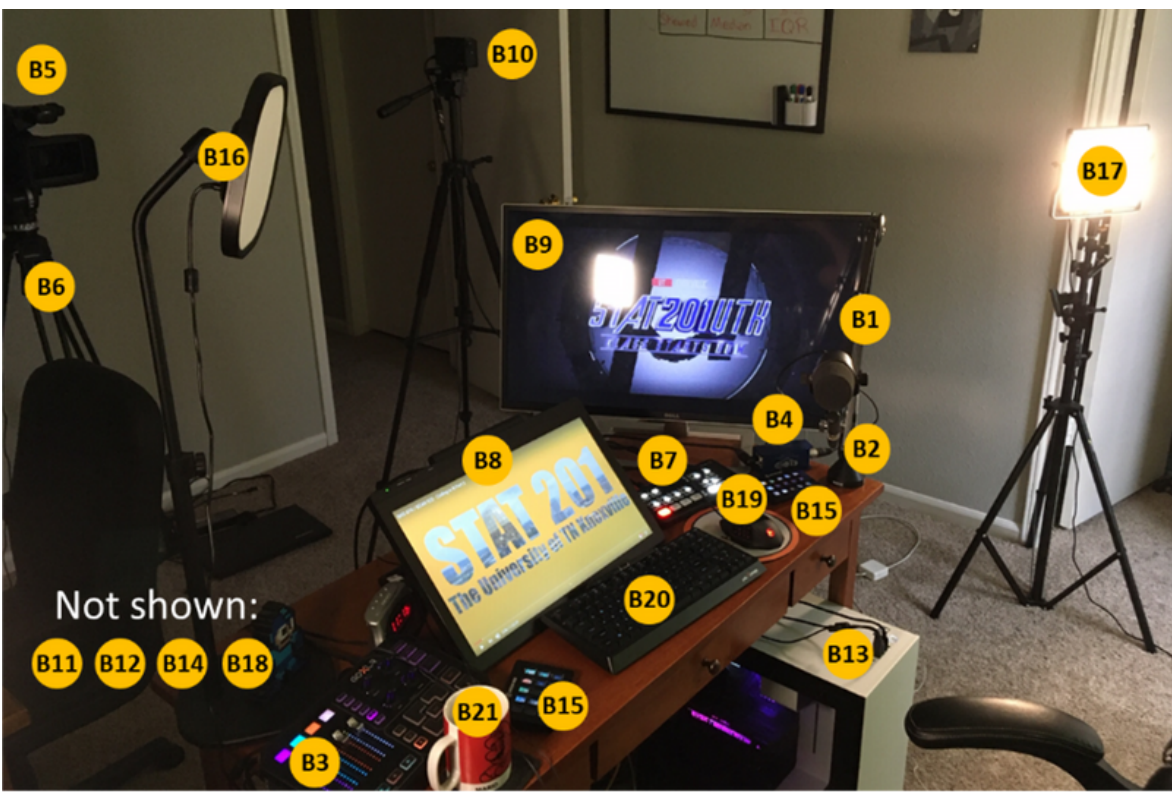
Figure D1. Brian Stevens’s home studio with labeled